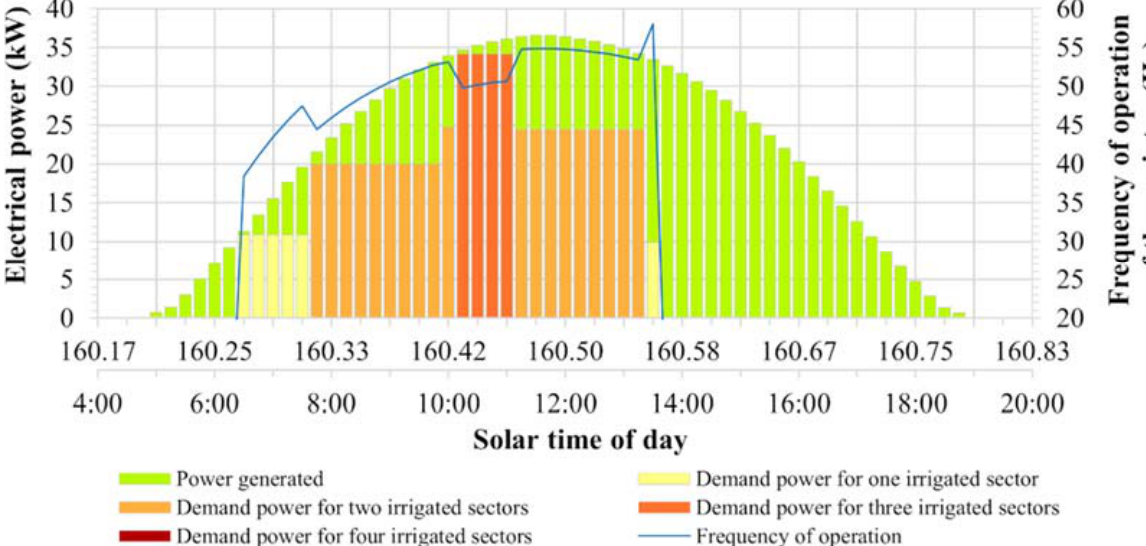
Figure 11. Graph of the minimum power of supply and demand for the combination of sectors established in the daily work matrix of the corresponding day. Moreover, the working frequency of the converter for transmitting the generated power to the hydraulic system is demonstrated.